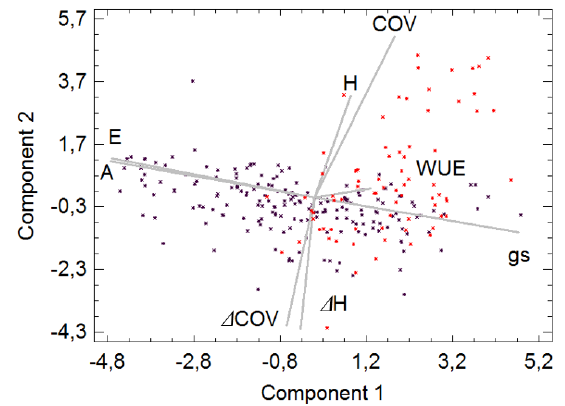
Figure 4. A principal component analysis including the recorded variables: total height ( H , mm), total cover ( COV , m 2 ), relative growth in height ratio ( ΔH ), coverage ratio ( ΔCOV ), transpiration ratio ( E , mmol m −2 s −1 ), net photosynthetic ratio ( A , μmol m −2 s −1 ), stomatal conductance ( gs , mol H 2 O m −2 s −1 ) and water use efficiency ( WUE) . Black dots: standardized values for obligate seeders ( R. officinalis and C. clusii ); Red dots: standardized values for resprouter ( S. tenacisiima ). The first component accounted for 39.38% and the second 20.82%, both accumulated 60.20% of the total variability contained in the original